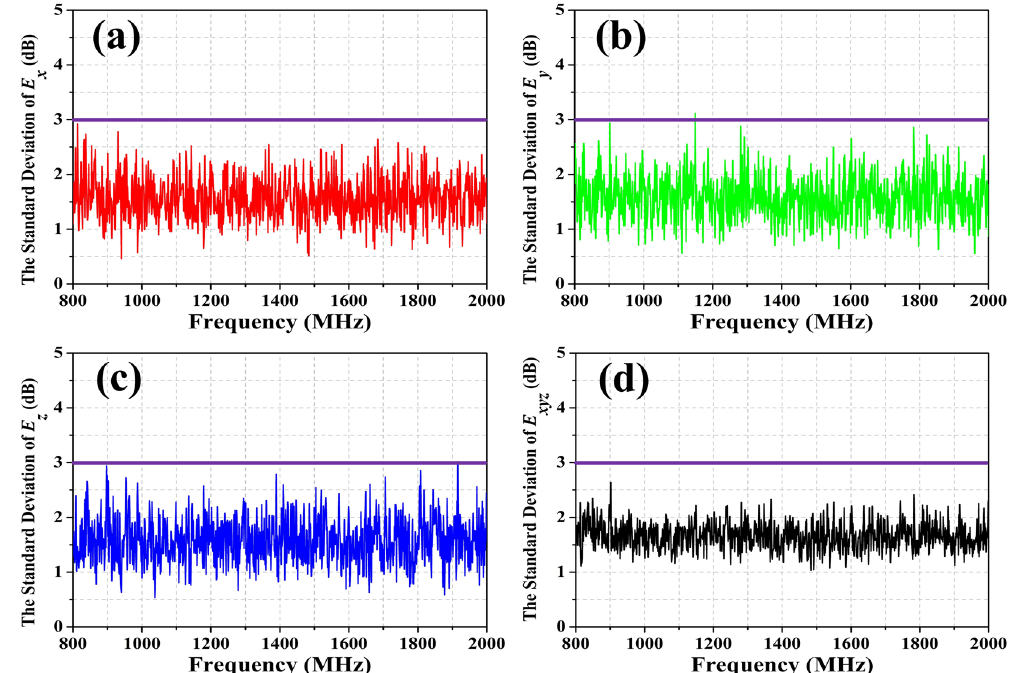
Figure 11. The standard deviations for the field uniformity of the test zone that loaded the rotating 1-bit random coding diffusion metasurface in the RC. The purple lines are the tolerance requirements for the standard deviation of 13 ; ( a ) the x-component, ( b ) the y-component, ( c ) the z-component, ( d ) the combination of xyz components.